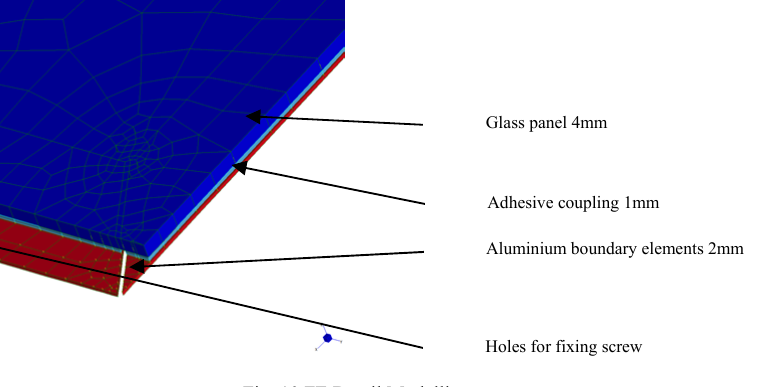
Fig. 10 FE Detail Modelling.